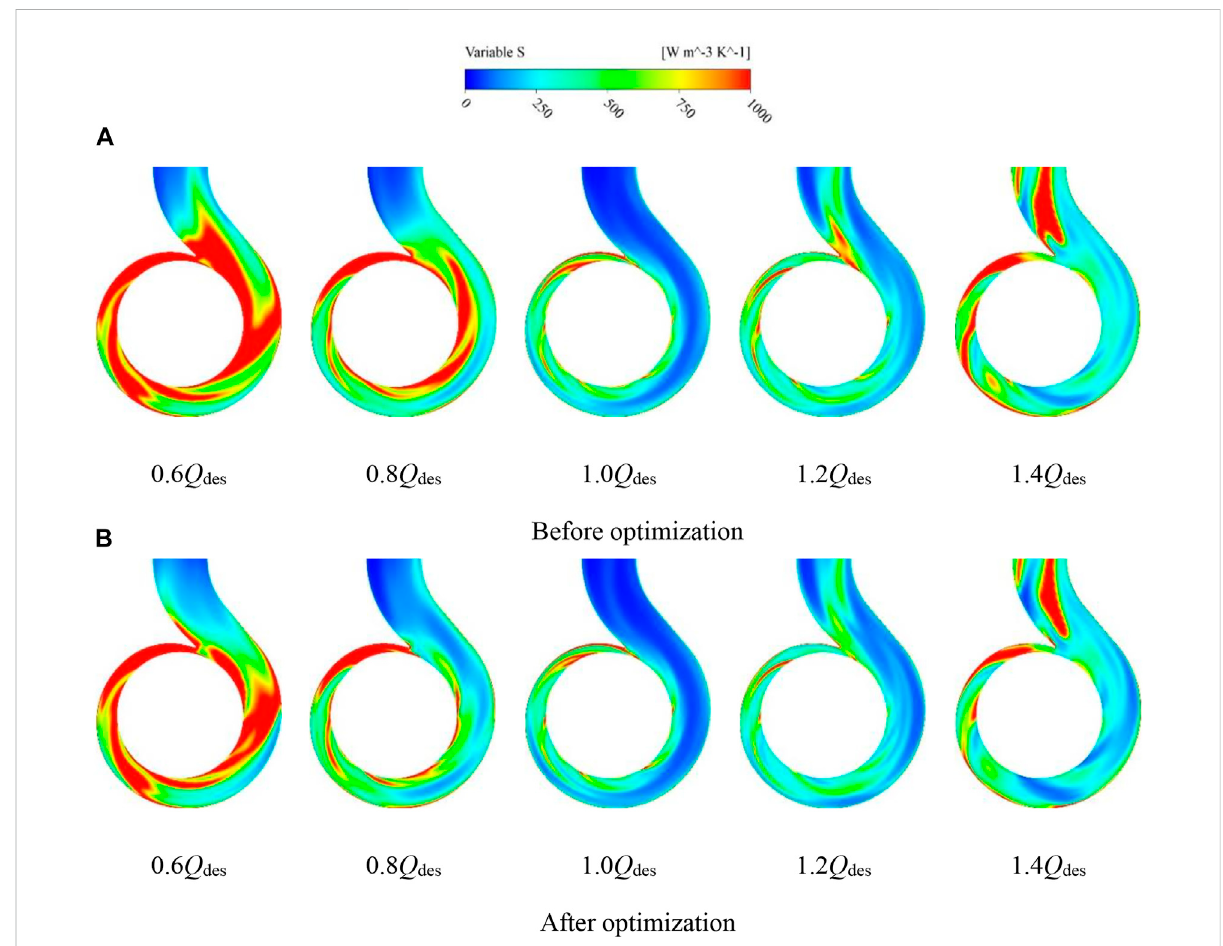
FIGURE 15 Entropy generation of volute cross-section at different working conditions before and after optimization. (A) before optimization (B) after optimization.